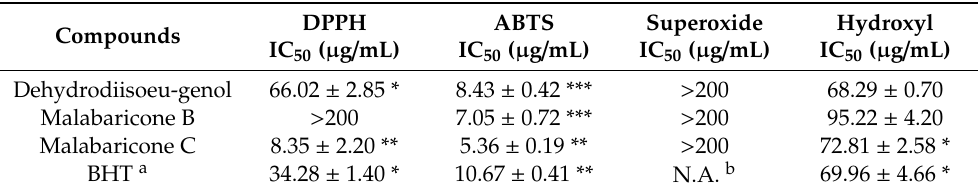
Table 5. The antioxidant activities of isolated components from Myristica fragrans determined with DPPH, ABTS, superoxide, and